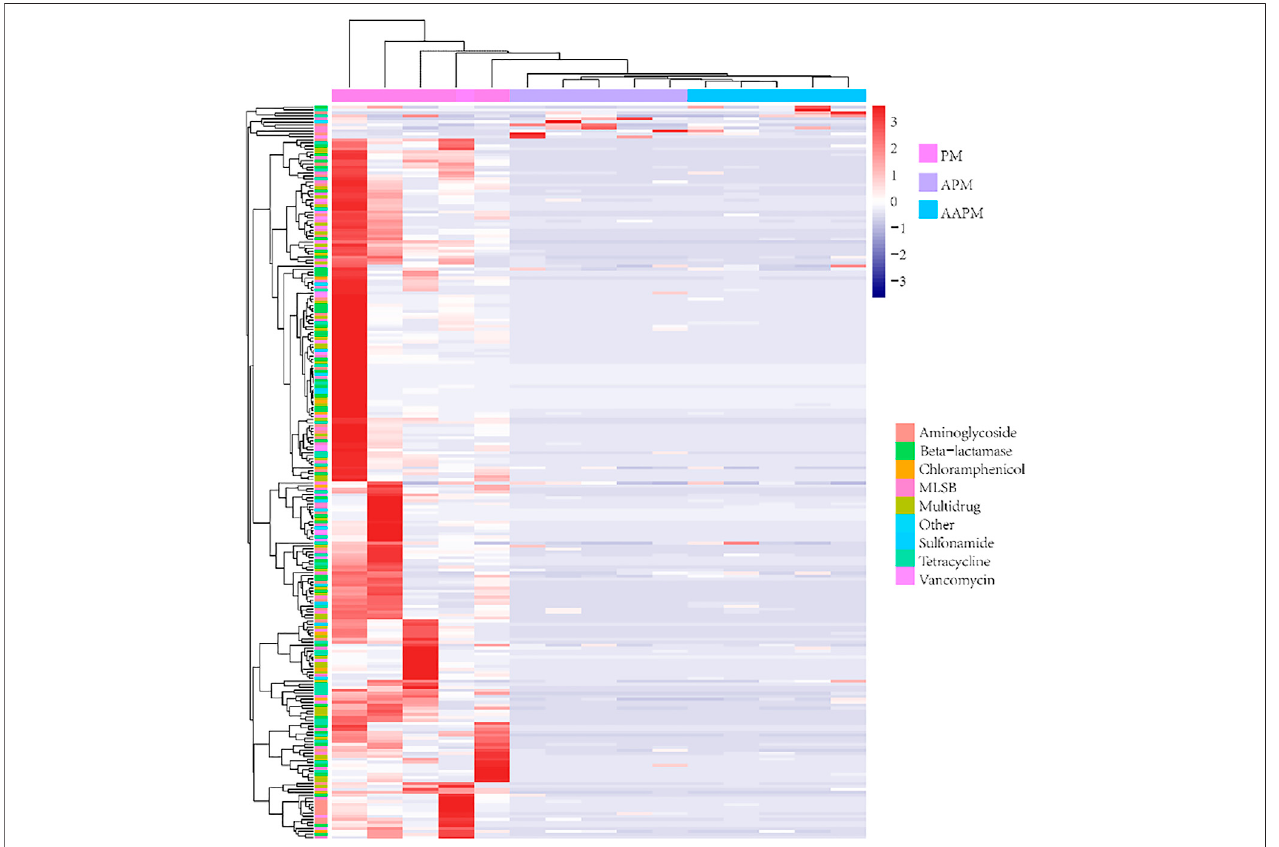
FIGURE 3 | Heatmap analysis of ARGs attached to strawberries collected from fi elds with long-term use of raw poultry manure (PM), aerobic composting poultry manure(APM),andanaerobiccompostingpoultrymanure(AAPM).TheARGsdetectedinthisstudyarelistedontheverticalaxis.Thehorizontalaxisshowsthesampling group ( n =